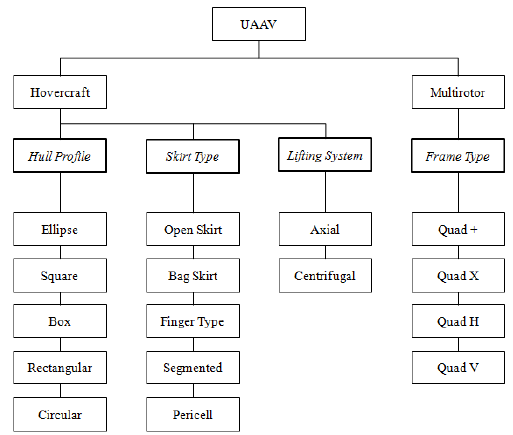
Figure 4. Morphological chart of UAAV